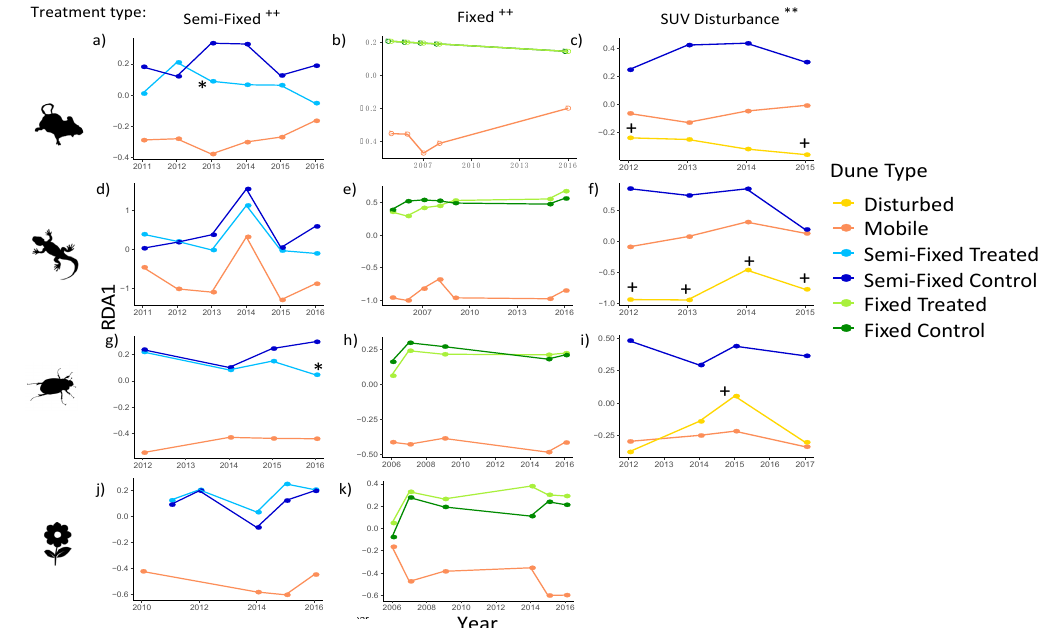
Figure 8. Temporal Redundancy Analysis (RDA) curves for each treatment type (see column titles) for ( a – c ) rodents, ( d – f ) reptiles, ( g – i ) beetles, and ( j – k ) annual plants. Scores on the first axis (RDA1) in constrained redundancy analysis with year as a covariable are plotted over time. Data points are the scores for centroids of each dune type in a given year for each taxon. p < 0.05 for all significant results; * Treated semi-fixed dunes were significantly di ff erent to untreated semi-fixed control dunes in specified years. ** Disturbed dunes were significantly di ff erent to un-treated semi-fixed control dunes in all years for all taxa. + Disturbed dunes were significantly di ff erent to reference Mobile dunes in specified years. ++ Treated dunes were significantly di ff erent to the reference in all years for all